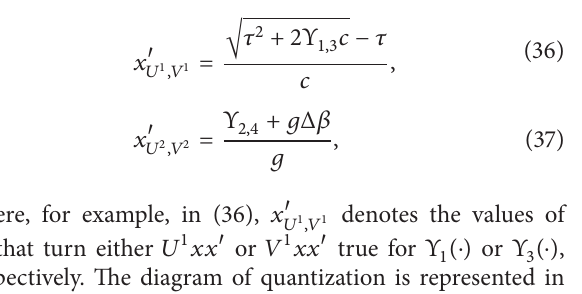
Figure 5. Each 𝑖 th original sample is chosen from array X on 𝑖 th iteration. The corresponding bit of a watermark is chosen from array b . Vector 𝜃 contains parameters of the quantization. At the end of each iteration, quantized value of 𝑖 th sample is written to array X 󸀠